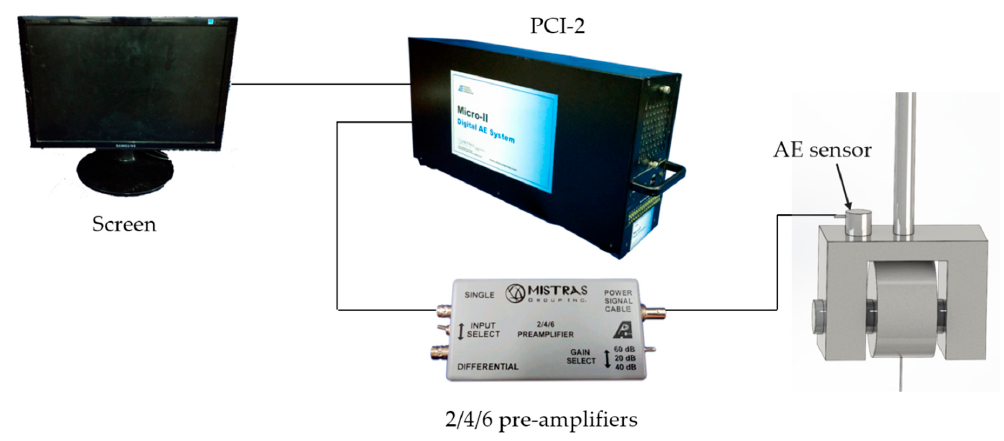
Figure 4. A diagram to illustrate the instrument connection for acoustic emission.